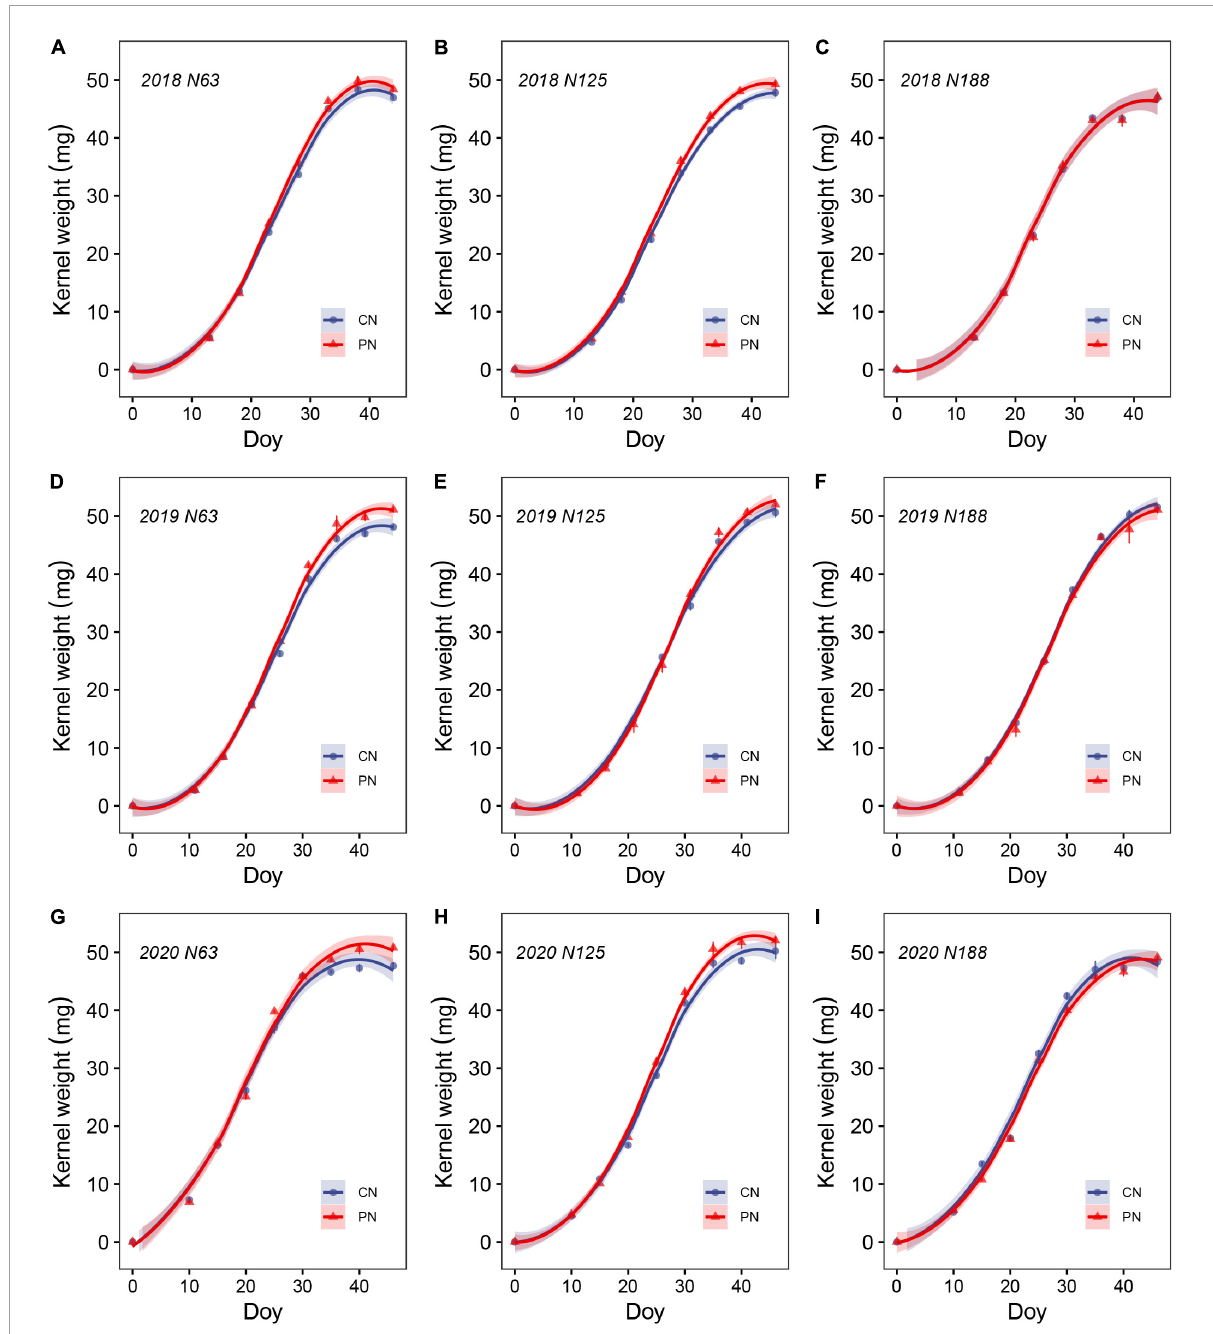
FIGURE5 Wheat kernel dry weight dynamics at N63 (A,D,G) , N125 (B,E,H) , and N188 (C,F,I) in the control (CN) and poly(aspartic acid)-coated urea (PN) treatments during the 2017–2018 (A–C) , 2018–2019 (D–F) and 2019–2020 (G–I) growing